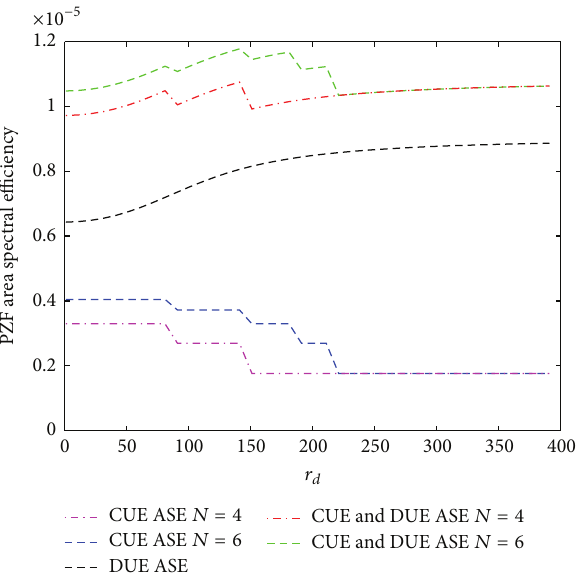
Figure 6: ASE with PZF